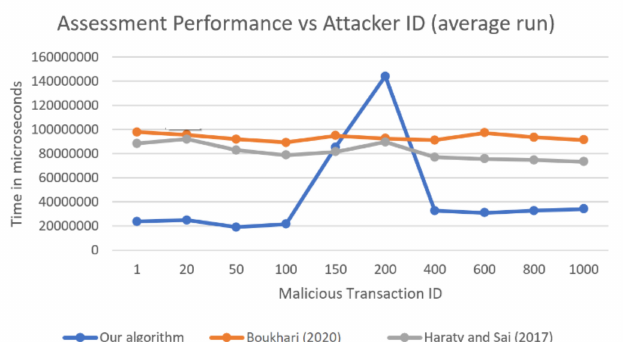
Figure 5. Comparison of the average times of three algorithms as a function of the malicious transaction